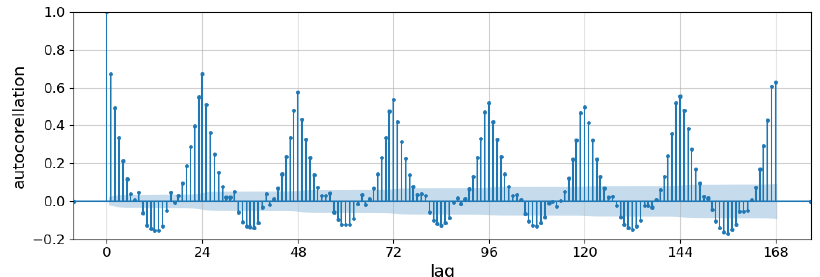
Figure 3. Autocorrelation coefficients for lags up to one week.